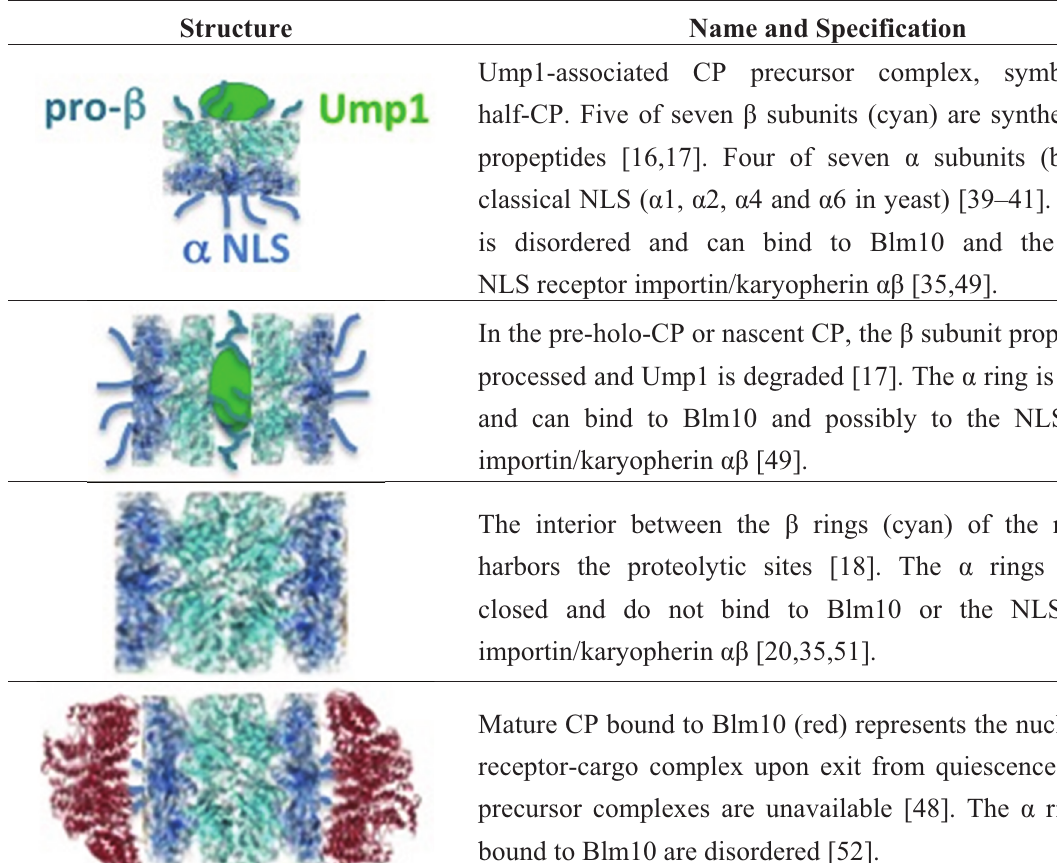
Table 1. CP configurations related to nuclear